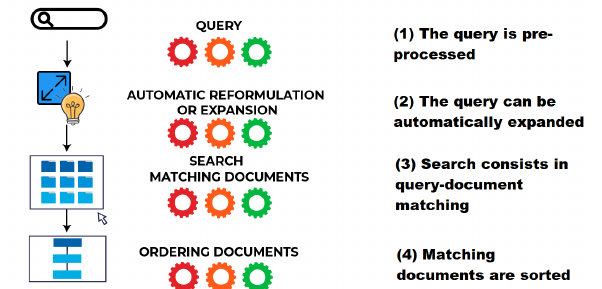
Figure 1. An online search process consists of four main phases to retrieve an ordered list of documents that answer the user’s query. The component used at each phase has various hyper- parameters to